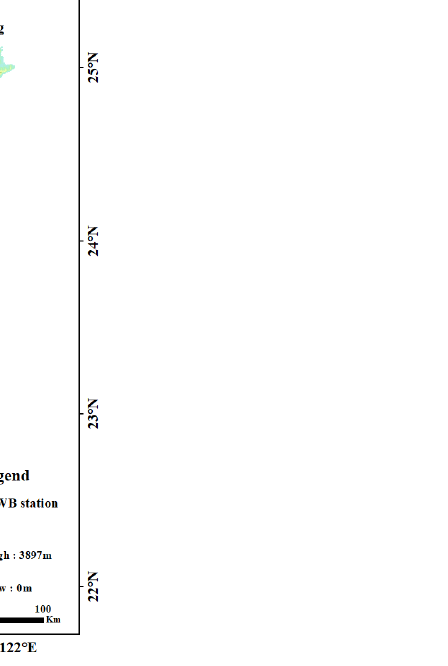
Figure 1. The main island of Taiwan and the location of ten Central Weather Bureau (CWB)